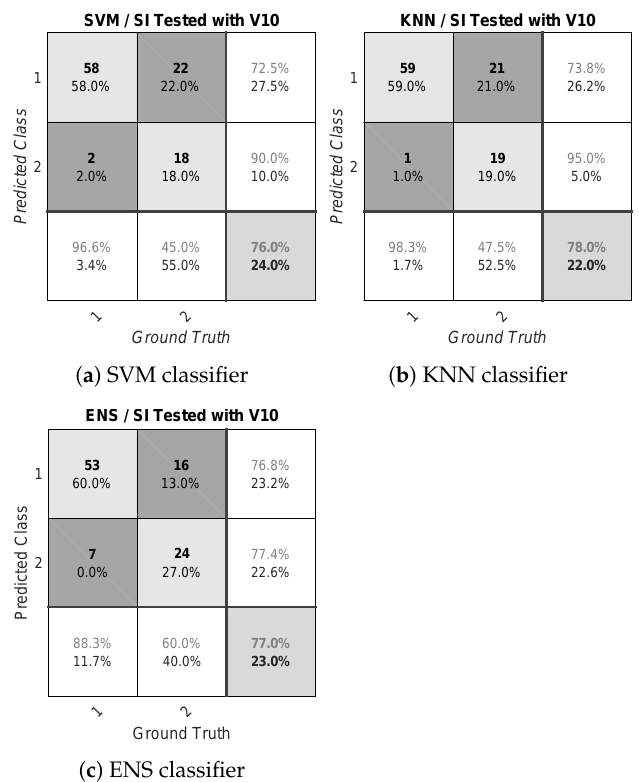
Figure A19. Confusion matrices for a subject-independent model tested with V9.